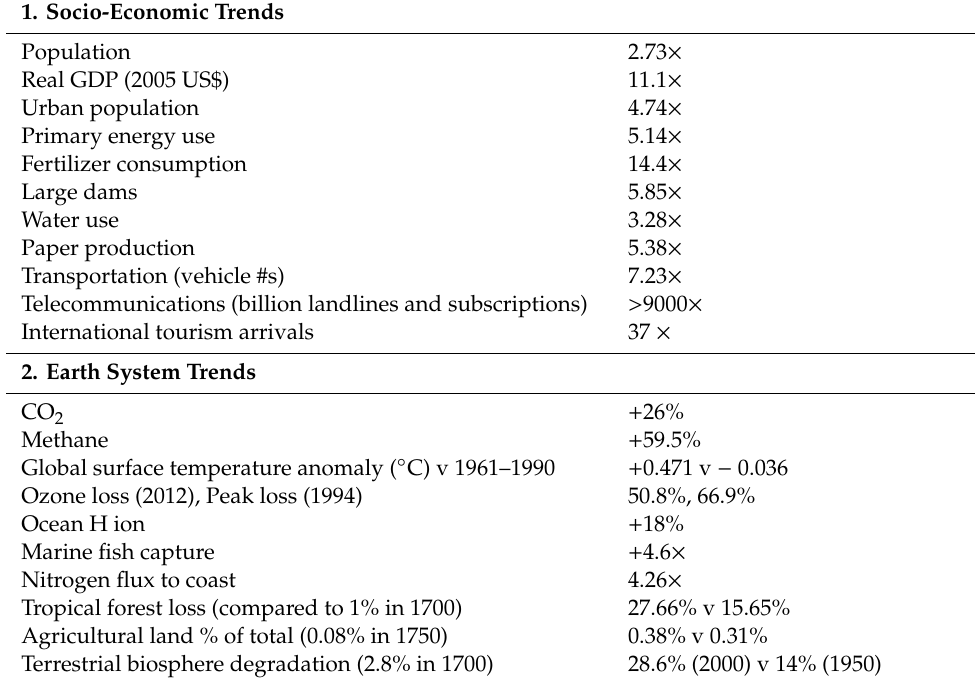
Table 1. My life in the Anthropocene. Changes in key socio-economic and Earth system indicators since 1948 or thereabouts (my year of birth) to about 2010 or 2012 (unless otherwise